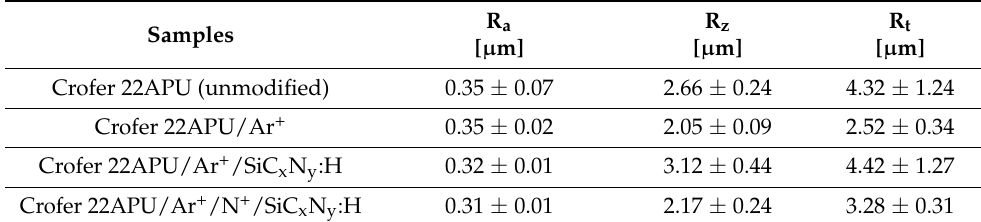
Table 2. Roughness parameters of the pure Crofer 22APU and after individual stages of surface modification.